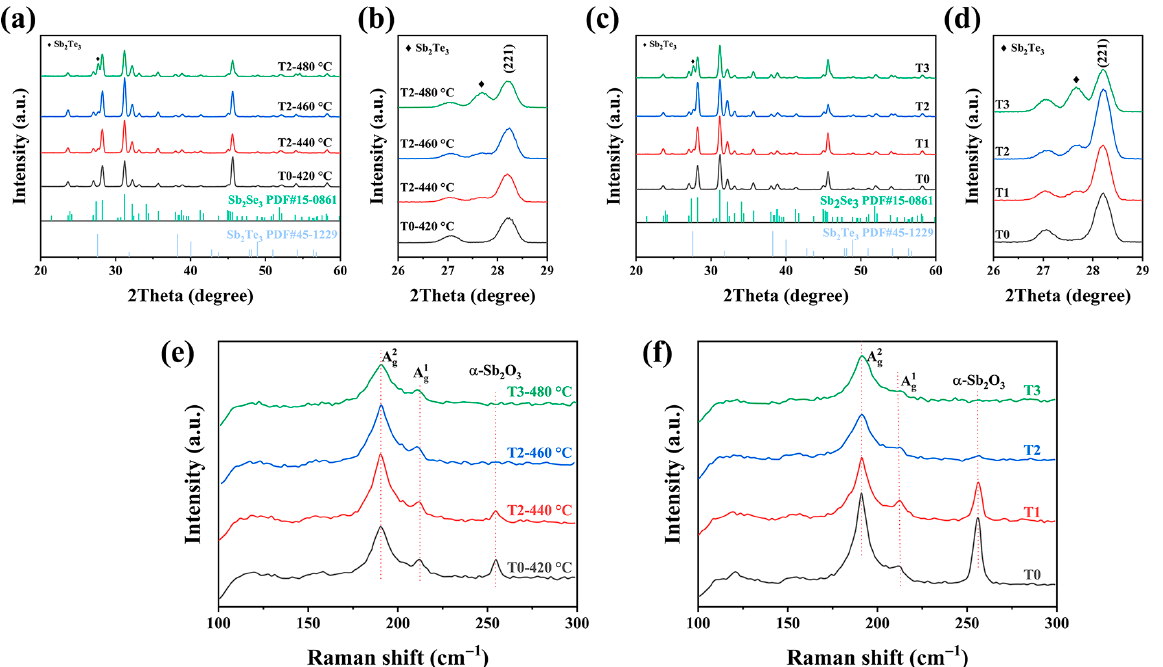
Figure 4. ( a ) Virgin Sb 2 Se 3 and Te-Sb 2 Se 3 thin fi lm XRD pa tt erns at various selenization temperatures, and ( b ) enlarged region of the XRD pa tt erns. ( c ) XRD pa tt erns of the pristine Sb 2 Se 3 and the Te-Sb 2 Se 3 thin fi lms at di ff erent weights of Te source, and ( d ) enlarged region of the XRD pa tt ern. ( e ) Raman spectroscopy of the virgin Sb 2 Se 3 and the Te-Sb 2 Se 3 thin fi lms under di ff erent selenization tempera- tures. ( f ) Raman spectroscopy of the virgin Sb 2 Se 3 and the Te-Sb 2 Se 3 thin fi lms under di ff erent weights of the Te source.